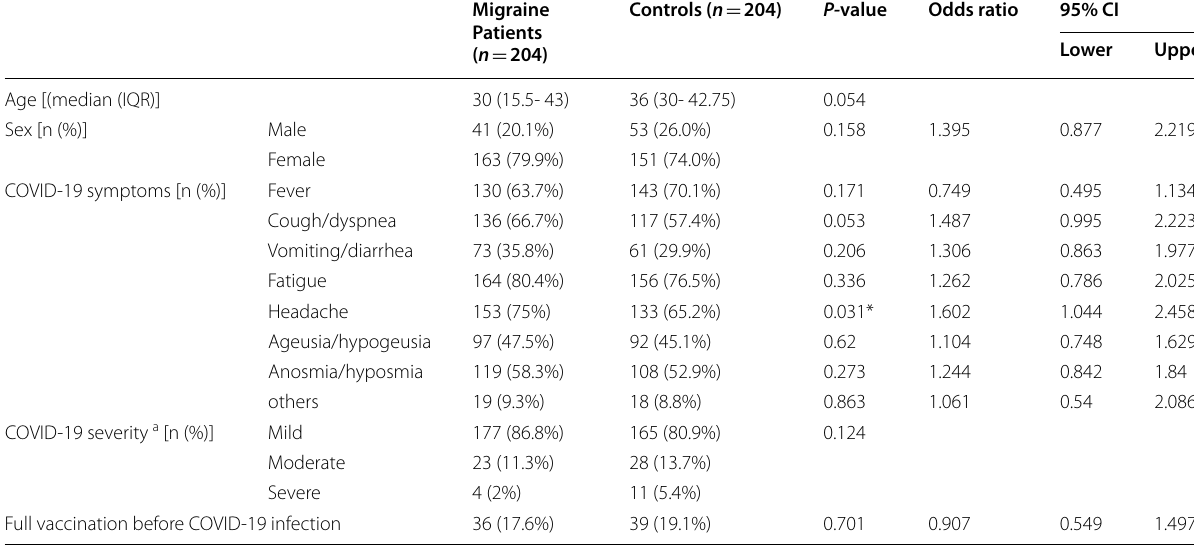
P- value 0.05 is considered significant ≤ a Risk Estimate statistics cannot be computed. They are only computed for a 2*2 table